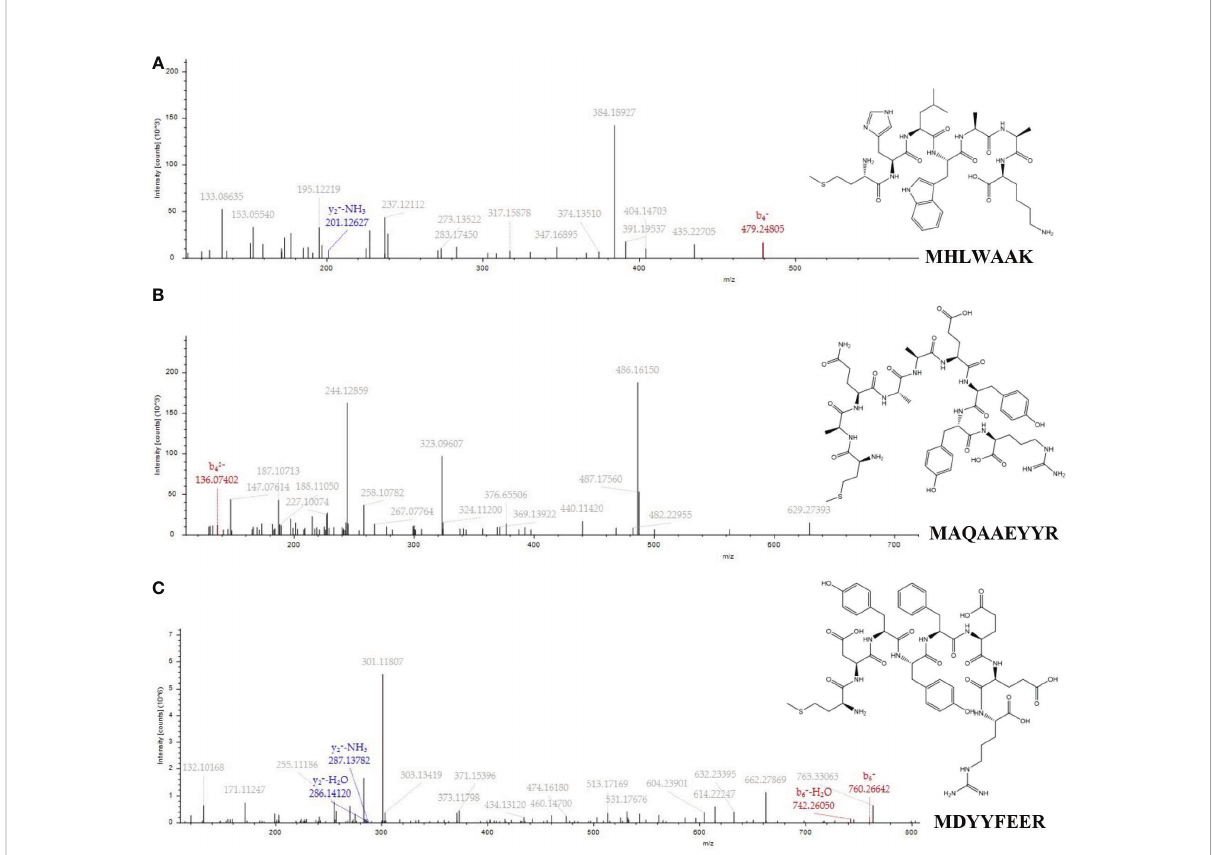
FIGURE 3 MS/MS spectra and structures of the three peptides from C-Phycocyanin (C-PC). (A) MHLWAAK. (B) MAQAAEYYR. (C)